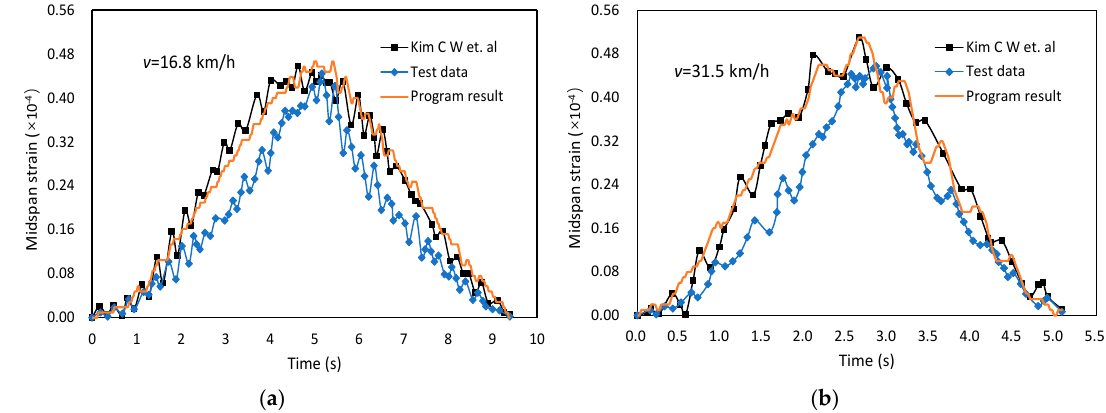
= 16.8 km / h ( b ) v = 31.5 km /